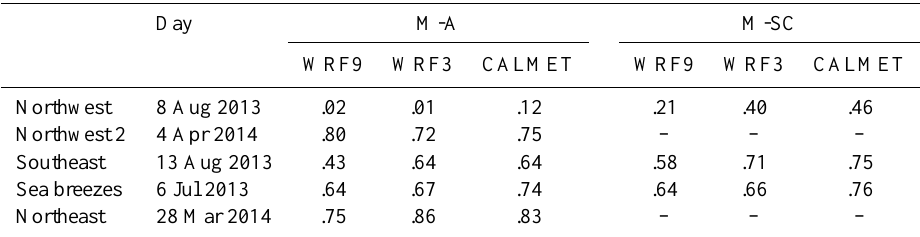
Figure 4. Taylor diagram for summer 2013 (a) and winter 2014 (b) for both M-A (coloured dot) and M-SC (coloured square filled with dot) model configurations (red for CALMET, black WRF3 and blue for WRF9) compared to corresponding meteorological stations. Both modelled standard deviations and RMSD are normalized over observational standard deviation. Table 2. Correlation among the three different atmospheric models and observational data for 3-day-long events during summer 2013 and winter 2014. No correlation for winter 2014 (M-SC dismantled on September